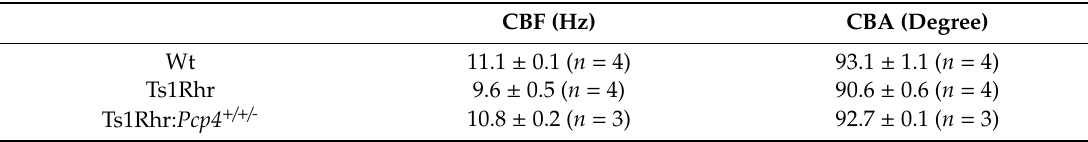
Table 1. CBFs and CBAs of airway cilia in Wt, Ts1Rhr, and Ts1Rhr: Pcp4 +/+/ - .